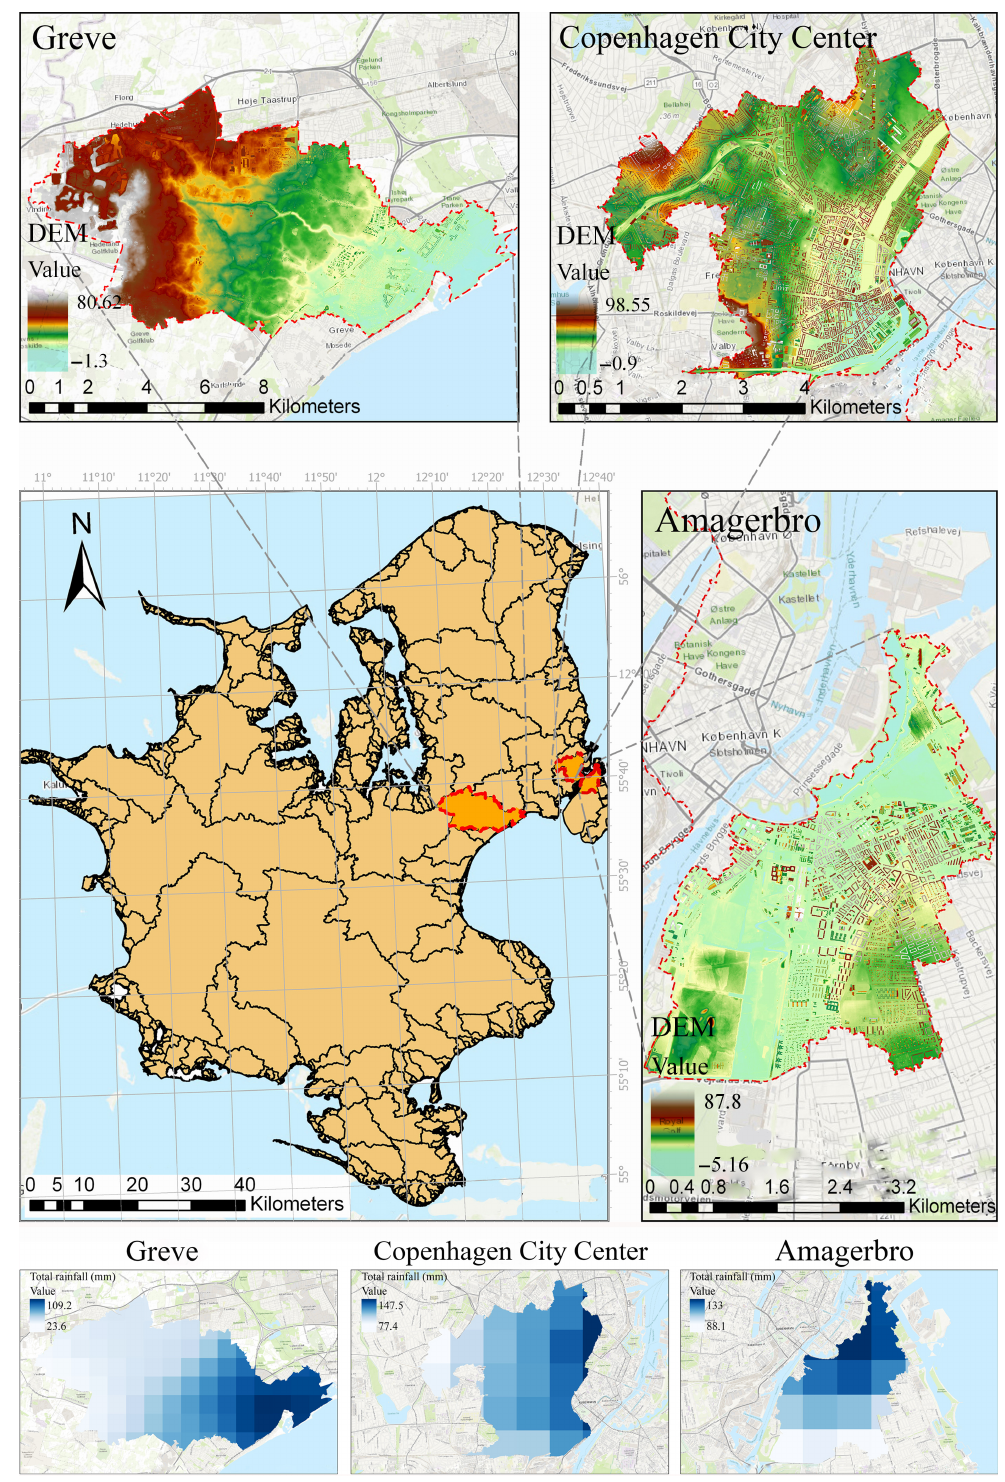
Figure 2. Locations and radar rainfall datasets for the three case areas: Greve, Copenhagen City Center and Amagerbro. Each radar rainfall cell represents the accumulated rainfall for an area of 1000 m × 1000 m. Base map shown in this paper is from source: Esri, DigitalGlobe, GeoEye, Earthstar Geographics, CNES/Airbus DS, USDA, USGS, AEX, Getmapping, Aerogrid, IGN, IGP, swisstopo, and the GIS User